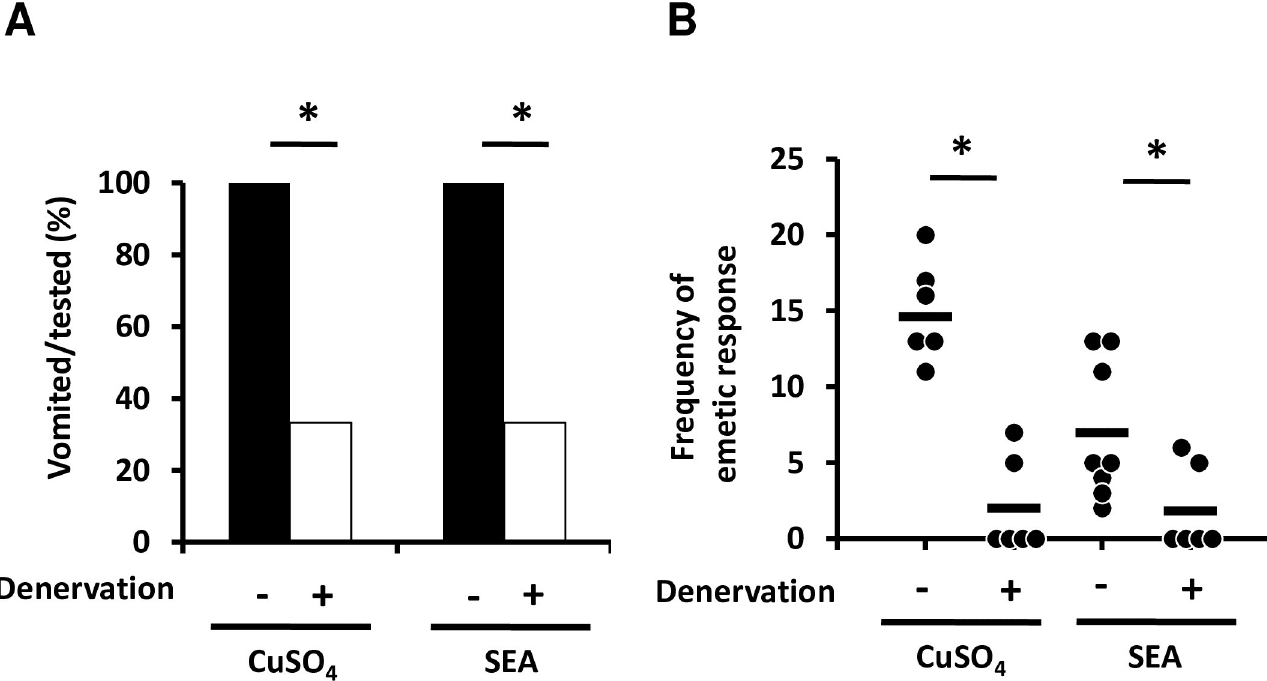
Fig 8. Stimulation of vomiting by SEA is transmitted via the vagus nerve. Vagotomized (n = 6) and sham operated (n = 6) common marmosets were administered 40 mg/kg of copper sulfate (left panel). Alternatively, vagotomized (n = 6) and sham-operated (n = 8) common marmosets were administered 250 μ g/kg of SEA (right panel). (A) The emetic response (percentage of vomited monkeys) and (B) its frequency were assessed as described in materials and methods. Each bar represents the mean ± SD. The statistical analysis was performed using Fisher’s exact test and the Mann-Whitney U test, � P < 0.05.